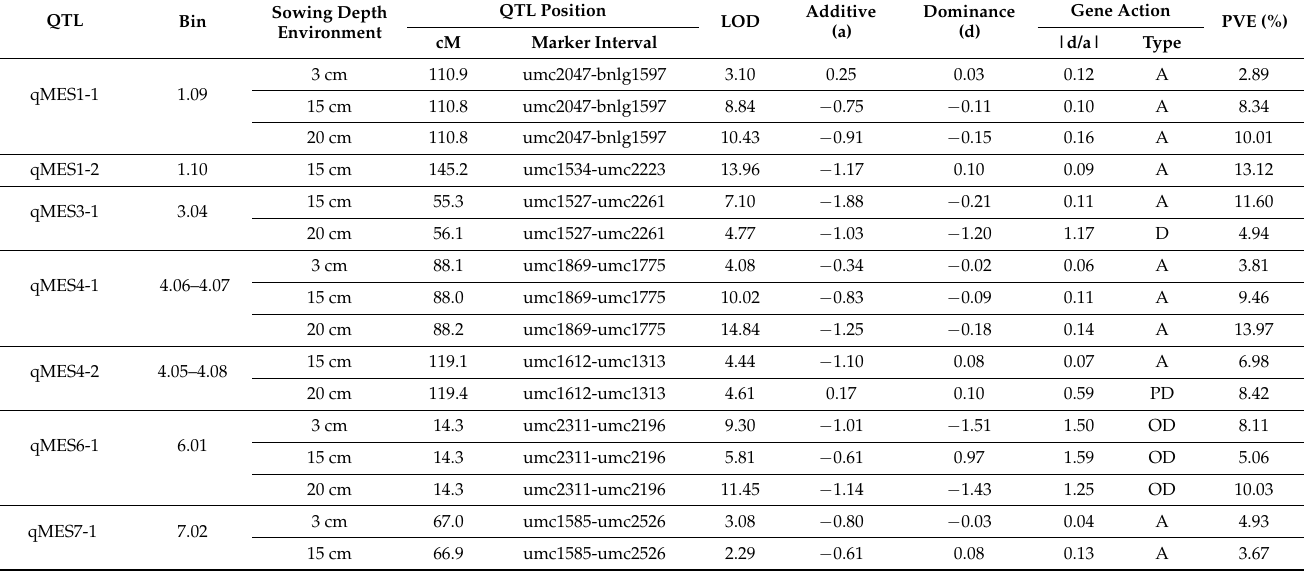
Table 1. QTLs detected for mesocotyl length (MES) in the F 2:3 population via single-environment mapping with composite interval mapping (CIM) under 3 cm, 15 cm, and 20 cm sowing environments,